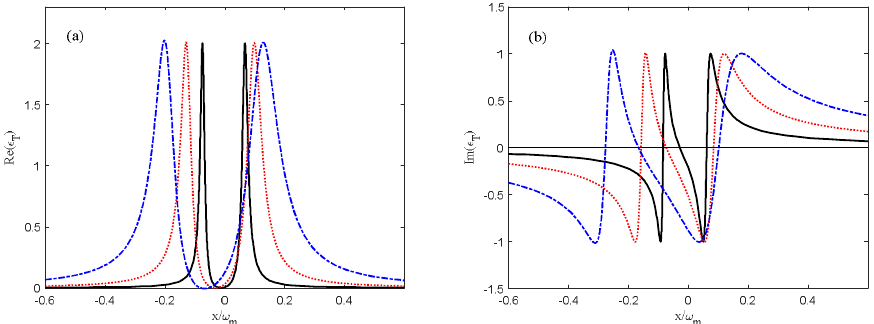
Figure 4. The output probe field amplitude ε T as a function of normalized detuning x / ω m for different decay rates κ of the optical cavity field. ( a ) Absorption spectrum. ( b ) Dispersion spectrum. Black solid line, red dotted line and blue dashed line represent the decay rate κ = 0.02 ω m , κ = 0.05 ω m and κ = 0.1 ω m , respectively.